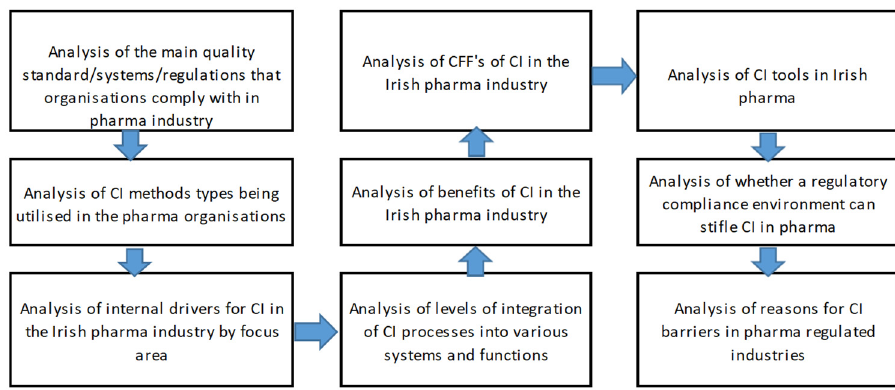
Figure 2. Research Analysis Plan.